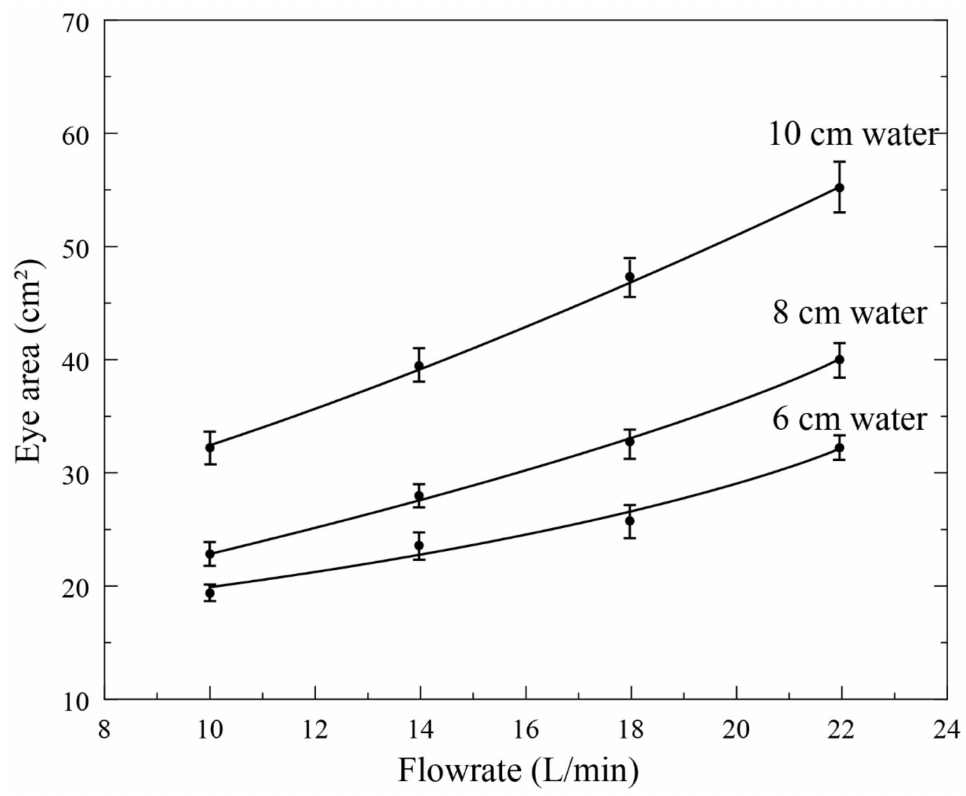
Figure 12. Effects of gas flow rate and water height on the plume eye area at a fixed oil thickness 4 cm. Reprinted with permission from ref. [54]. Copyright 2021 Springer